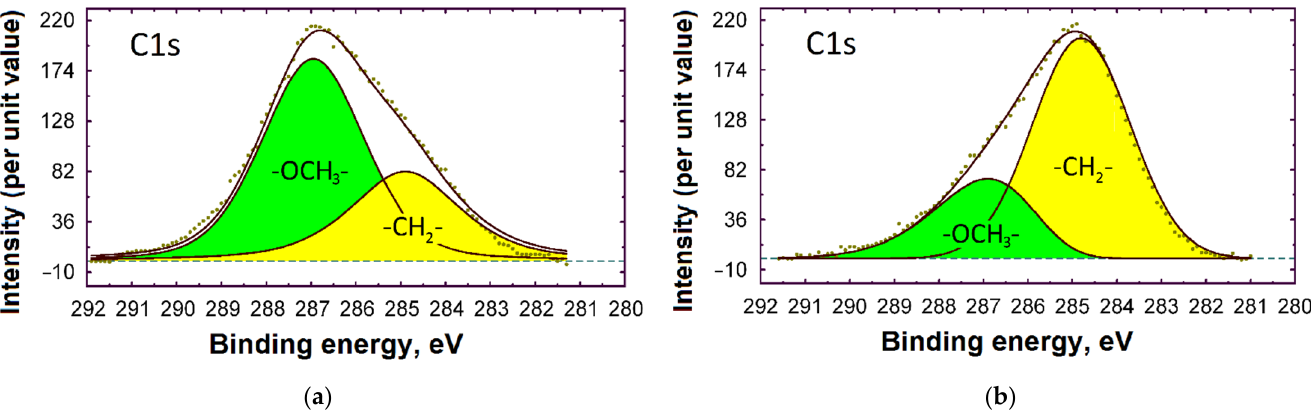
Figure 7. C1s spectra of samples with various immersion times in a hydrophobic inhibitor solution: ( a ) 10 min; ( b ) 60 min.